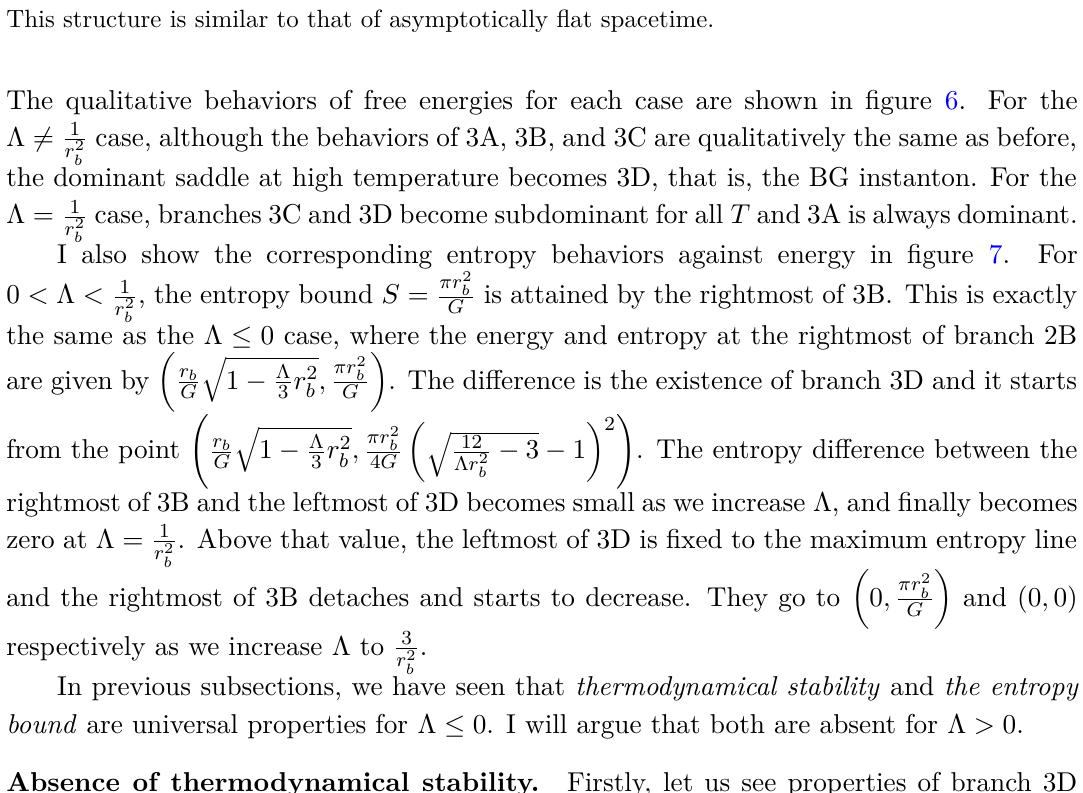
Figure 6 . Qualitative behaviors of free energies for 0 < Λ < 3 T tr , branch 3A dominates; above T tr , branch 3D dominates. ( Right ) Λ = 1 always dominates and there exist (thermodynamically unstable) subdominant branches for all T